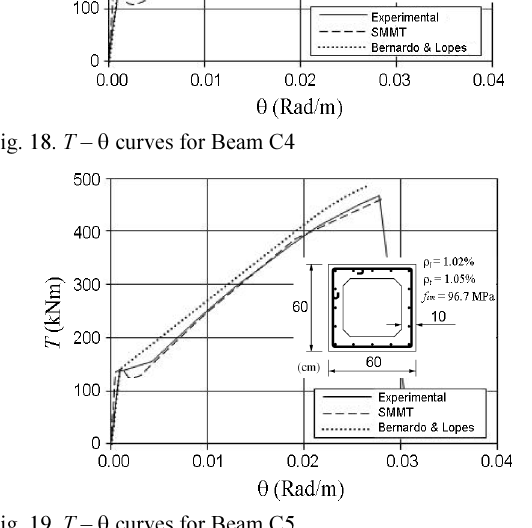
Fig. 22. T – θ curves for Beam D1